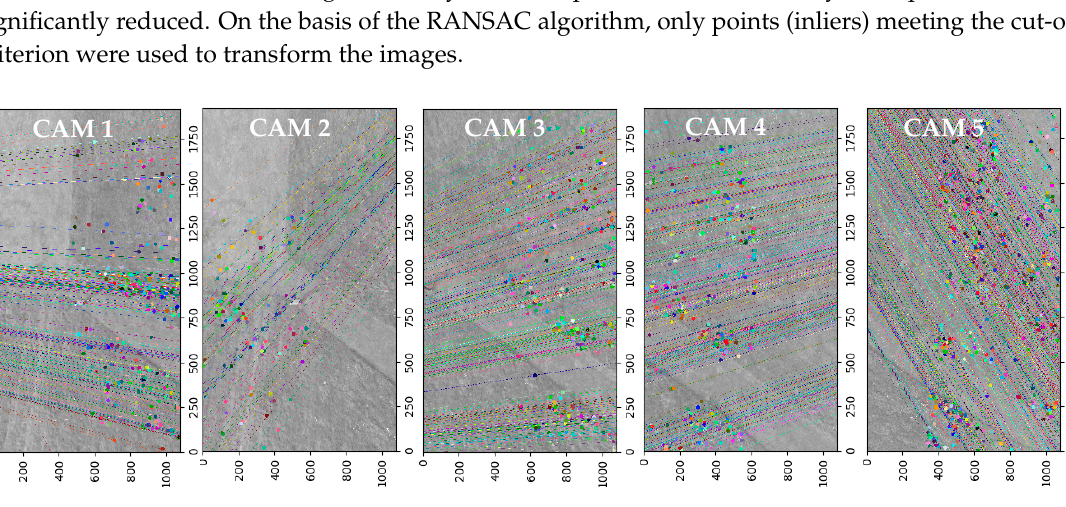
Figure 9. The distribution of matching points (using the best correspondences) for images acquired by every camera.